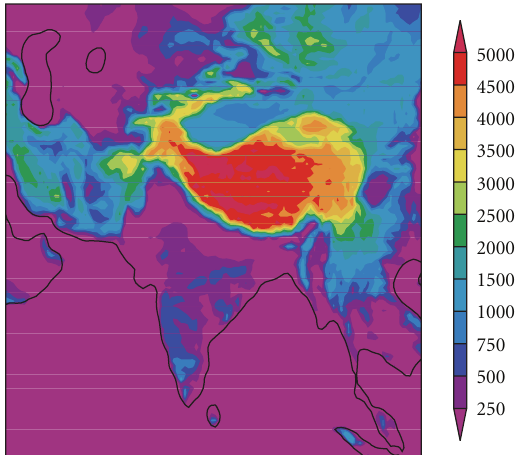
Figure 1: Integration domain and orography (m; shaded) of